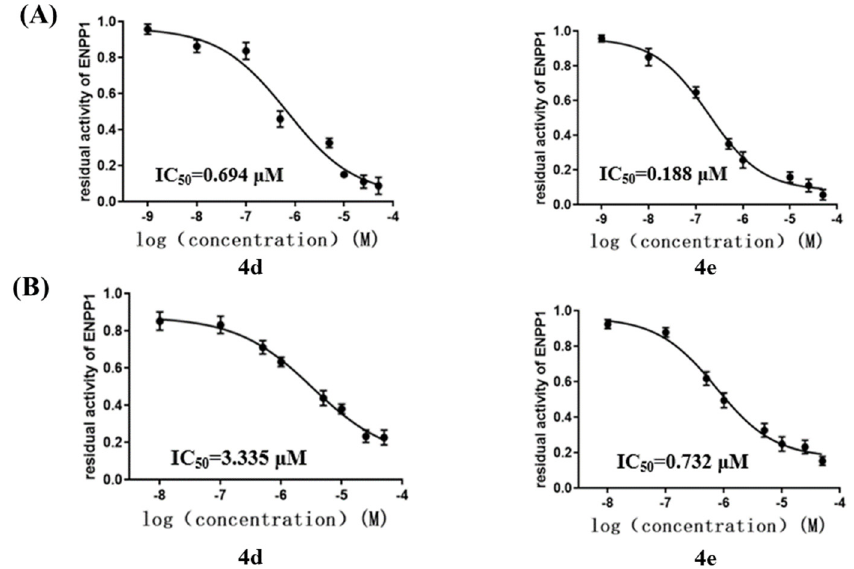
Figure 5. ( A ) IC 50 values of inhibitors of ENPP1, presented as mean ± SD with three independent enzymatic assays. ( B ) IC 50 values of inhibitors of ENPP1 in MDA − MB − 231 cell line, presented as mean ± SD with three independent cell assays.